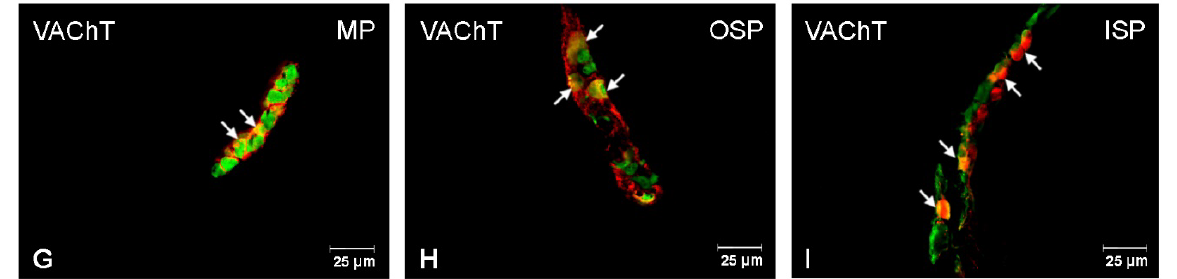
Figure 4. Fluorescence microscopy images showing protein gene product 9.5 (PGP 9.5) visible as green fluorescence that colocalizes with vesicular acetylcholine transporter (VAChT) visible as red fluorescence in the enteric neurons of the jejunum in pigs. The obtained images were created by computer superimposition of two channels (green and red). The photos show the enteric nervous system neurons of the pig’s jejunum under physiological conditions ( A , D , G ) and after administration of low ( B , E , H ) and high ( C , F , I ) doses of acrylamide. Neurons immunoreactive for particular substances are advisable with arrows. MP—the myenteric plexus; OSP—the outer submucosal plexus; ISP—the inner submucosal plexus.